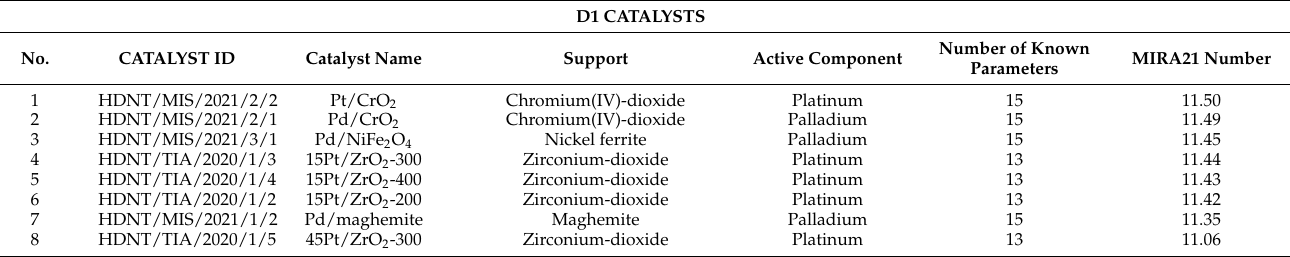
Figure 12. Distribution and active components of catalysts according to MIRA21 ranking and classification (D1-best, Q4-worst qualification, according to MIRA21 coloring). Table 1. TOP10 catalyst of MIRA21